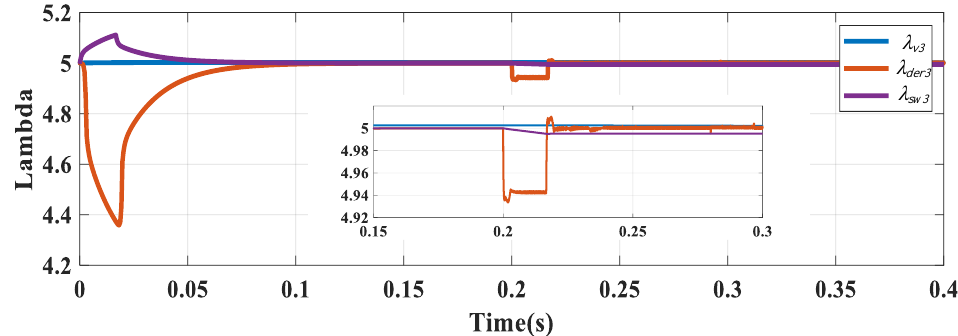
Figure 17. Study 2: generated weighting coefficients for FCS-MPC in DG3.